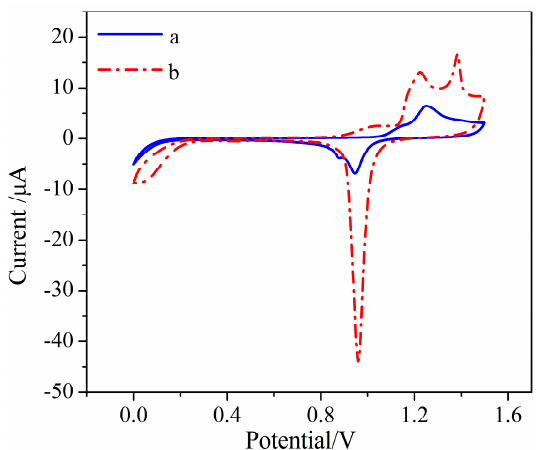
Figure 6. The cyclic voltammetry of the AuNPs–BDD electrode with anodic (a) and cathodic (b) pretreatment after AuNPs deposition in 0.5 mol/L H 2 SO 4 .